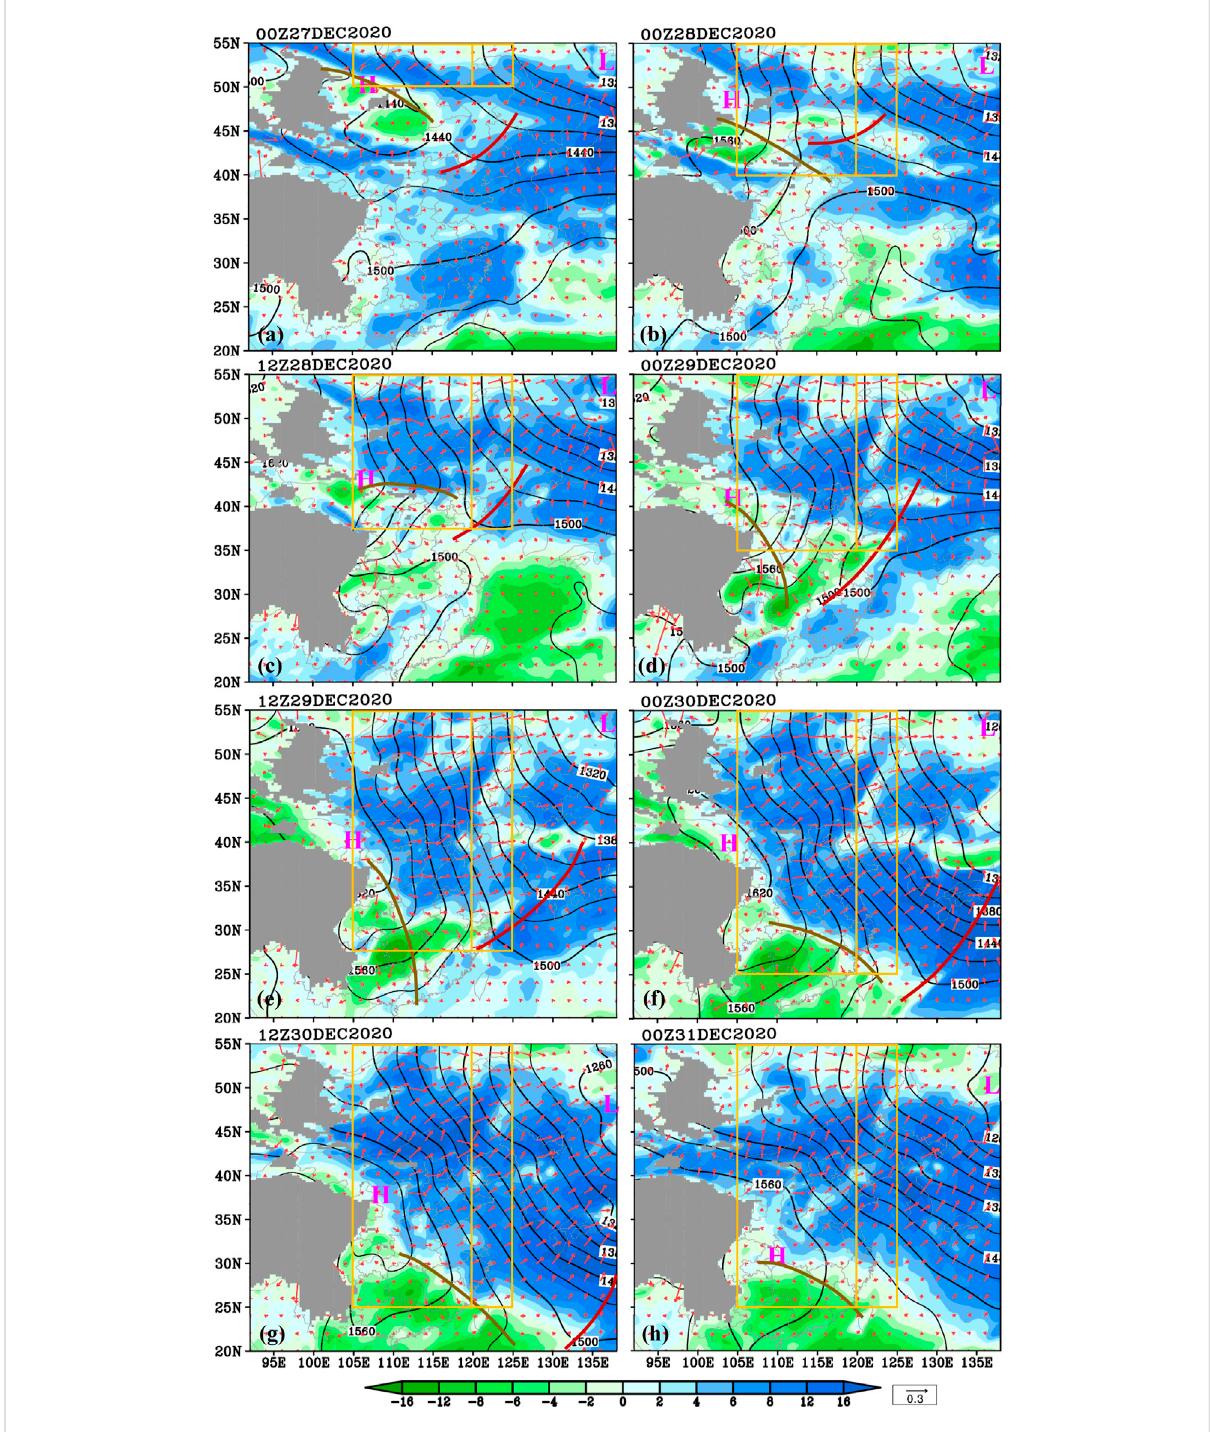
FIGURE 10 Zonal wind (shading; m s − 1 ), geopotential height (black contours; gpm), and − ∇ Φ (red vectors; m s − 2 ) at 850 hPa. Gray shading = terrain above 1,500 m. ‘ H ’ high-pressure system. ‘ L ’ = low-pressure system. Thick red lines = trough lines. Thick brown lines = ridge lines. Yellow boxes = FR1/ FR2 of the cold wave